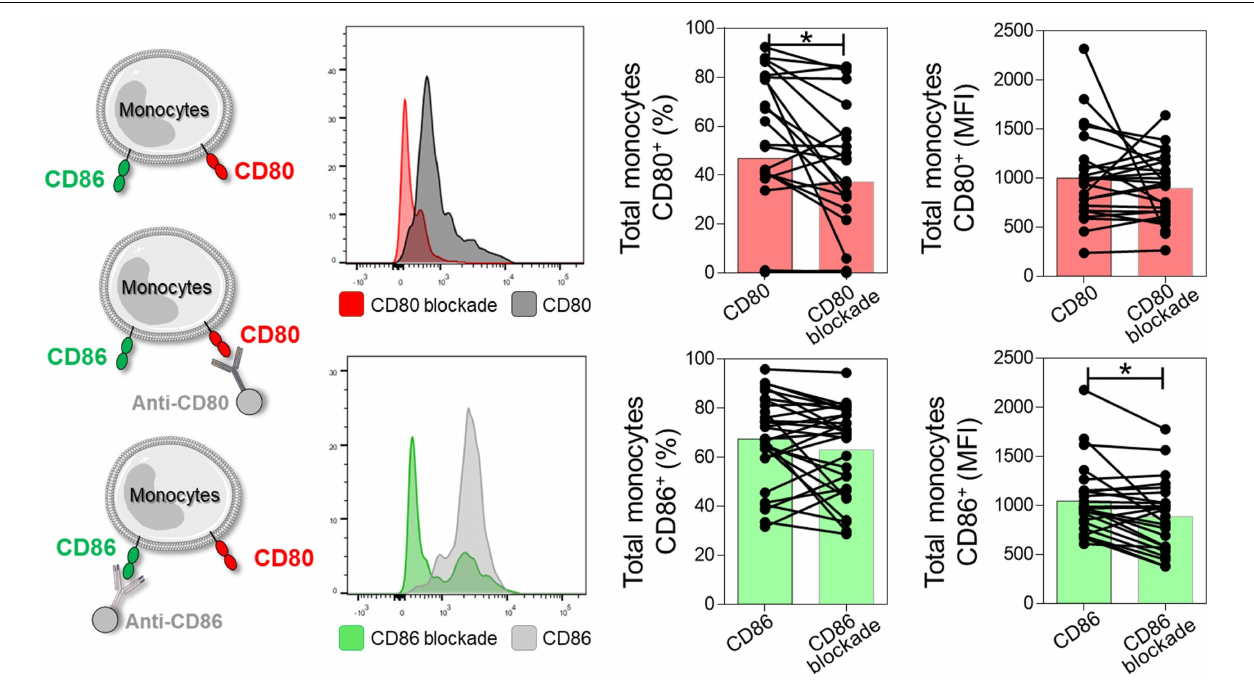
FIGURE 1 | Representation of the reduction of CD80 and CD86 molecules after antibody blockade. Histogram representation, frequency of CD80 + or CD86 + monocytes, and mean fluorescence intensity (MFI) after and before anti-CD80 and anti-CD86 antibody blockade of PBMC cultures from total group (NI, IND, and CARD, n = 29). For this analysis, monocytes were delimited through granularity (SSC) vs. HLA-DR parameters and subsequent evaluation of the CD80 and CD86 co-stimulatory molecules. Statistical differences ( p < 0.05) were obtained by Wilcoxon signed-rank test. Bars represent the median values.